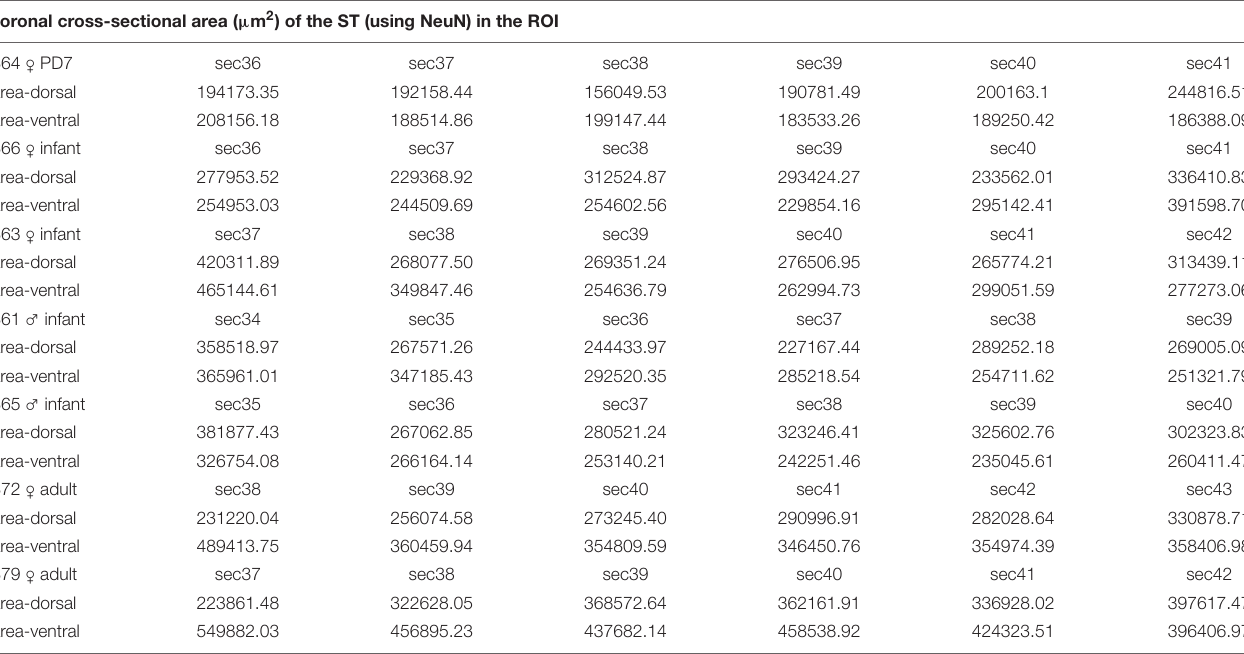
TABLE 4 | Cross-sectional areas of the dorsal stria terminalis (dST) and ventral stria terminalis (vST) measured in six sections per brain. Coronal cross-sectional area ( µ m 2 ) of the ST (using NeuN) in the